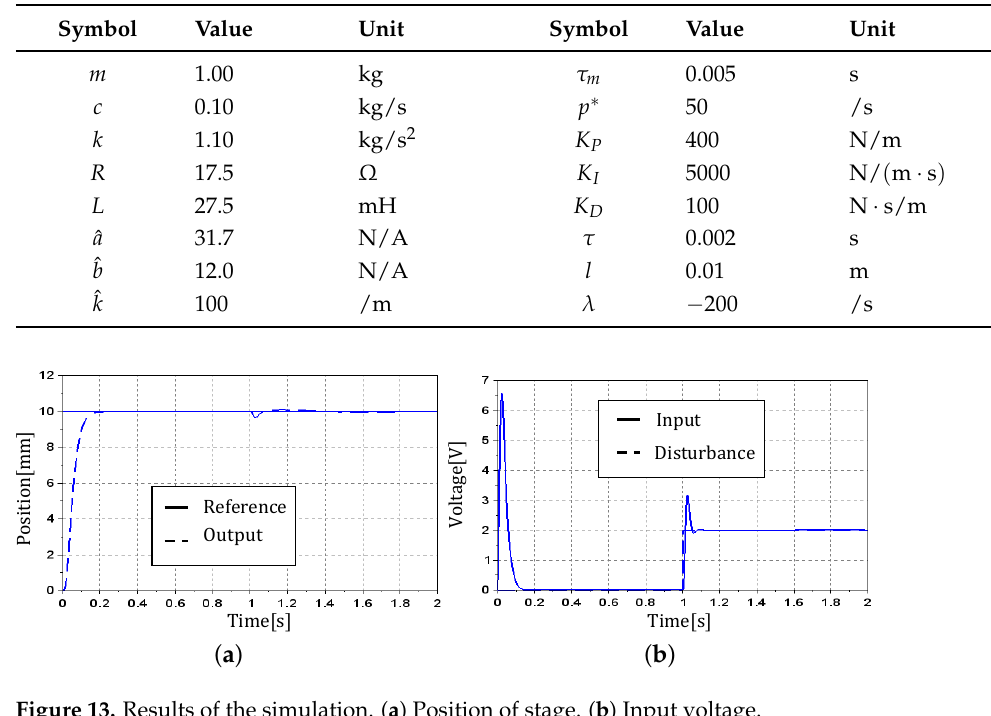
Figure 13. Results of the simulation. ( a ) Position of stage. ( b ) Input